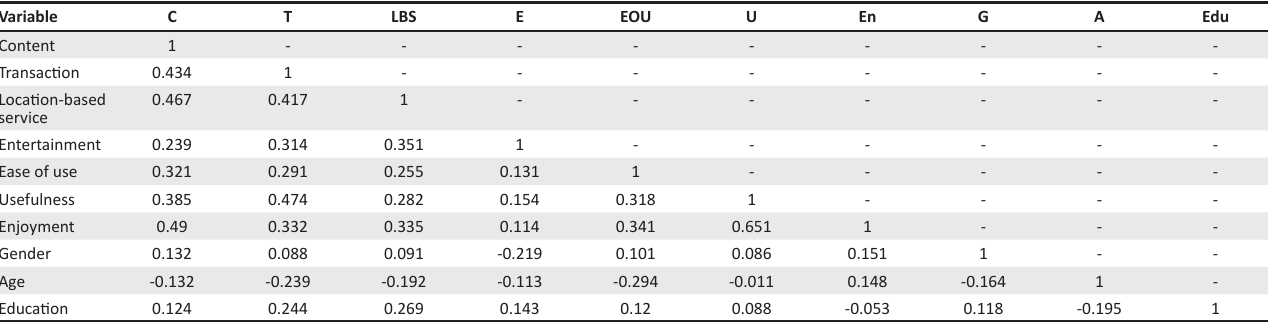
TABLE 3: Correlation